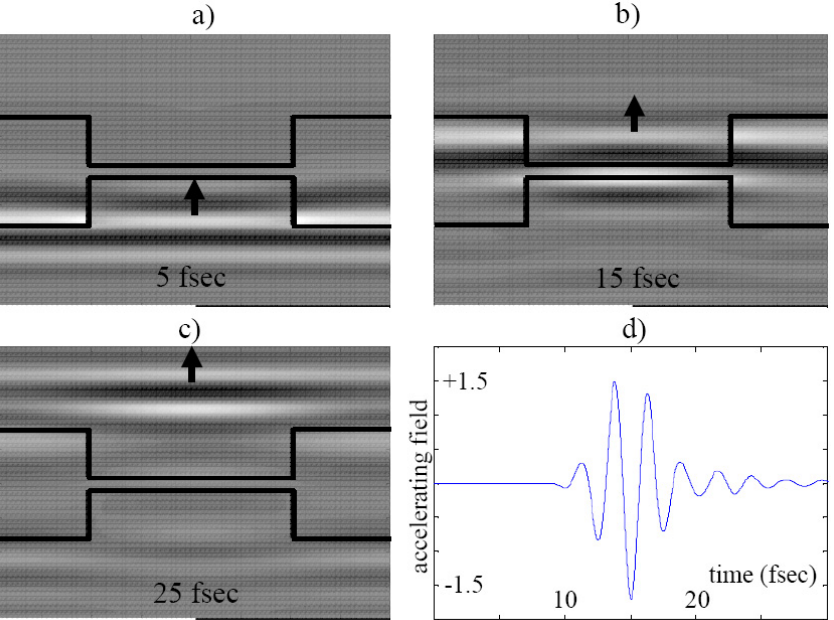
(cid:1) 5 fs plane wave of center wavelength (cid:3) (cid:4) 800 nm in a quartz-based grating ( n (cid:4) FIG. 7. (Color) (a,b,c) Propagation of a (cid:5) laser 1 : 55 ). Each frame corresponds to a 5 fs time increment. The arrow indicates the direction of the wave. (d) Instantaneous longitudinal electric field at the vacuum gap channel center as a function of